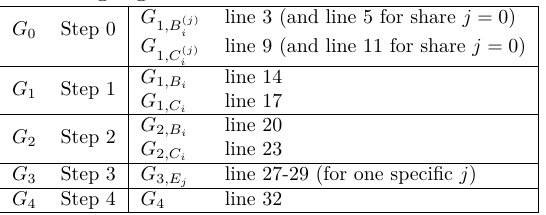
Table 1: Overview of gadgets and their relation to the lines in Algorithm